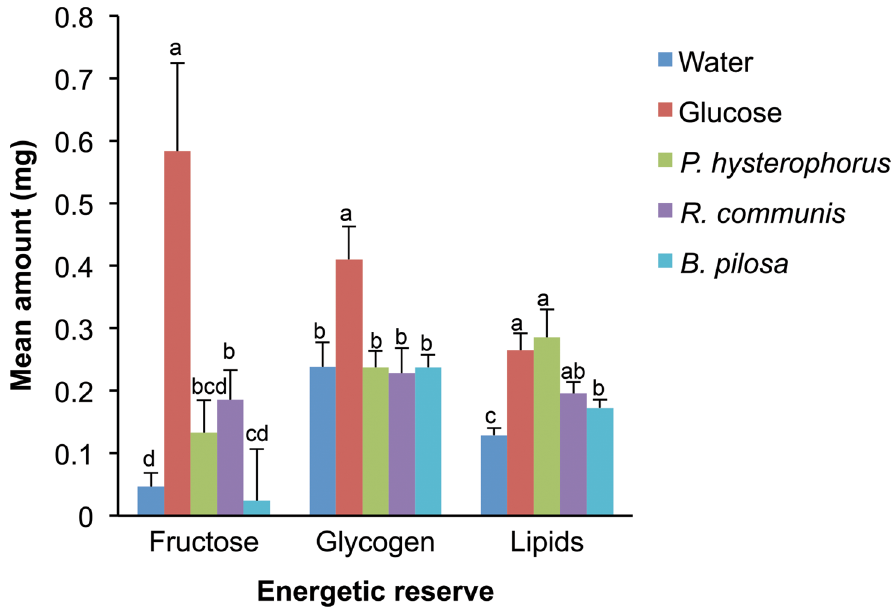
Fig 3. Energy reserves (sugar, glycogen and lipid content) of female An . gambiae exposed to different nutritional regimes after 7 days. Bars capped with different letters are significantly different.